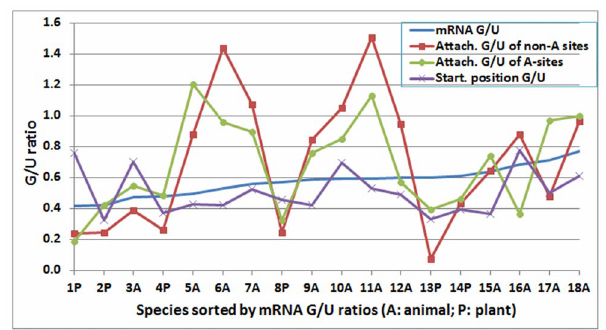
Figure 5. The G/U ratios in messenger RNA (mRNA) sequences, the polyadenylation [poly(A)] tail attachment position of A- type poly(A) sites, the poly(A) tail attachment position of non- A-type poly(A) sites, and the poly(A) tail starting position. The species were sorted from smallest ( # 1) to largest ( # 18) by their mRNA G/U ratios. The order of species from 1 to 18 is Medicago truncatula (1P), Arabidopsis thaliana (2P), fruit fly (3A), poplar (4P), zebrafish (5P), chicken (6A), cattle (7A), rice (8P), mouse (9A), orangutan (10A), zebra finch (11A), human (12A), sorghum (13P), maize (14P), rat (15A), dog (16A), rabbit (17A), and pig (18A). Note that the G/U ratios for the poly(A) tail starting positions were generally lower than the mRNA G/U ratios, a finding that means that G was less favoured than U at the poly(A) tail starting position. Note also that the G/U ratio at the poly(A) tail attachment position did not correlate with the mRNA G/U ratio, but eight species highly favoured G over U at the poly(A) attachment position, regardless of whether the poly(A) tail starting position was an adenosine. The correlation between the poly(A) tail attachment position of non-A-type poly(A) sites (‘‘Attach. G/U of non-A sites’’) and the poly(A) tail attachment position of A-type poly(A) sites (‘‘Attach. G/U of A sites’’) was significant ( r =0.74, P ,